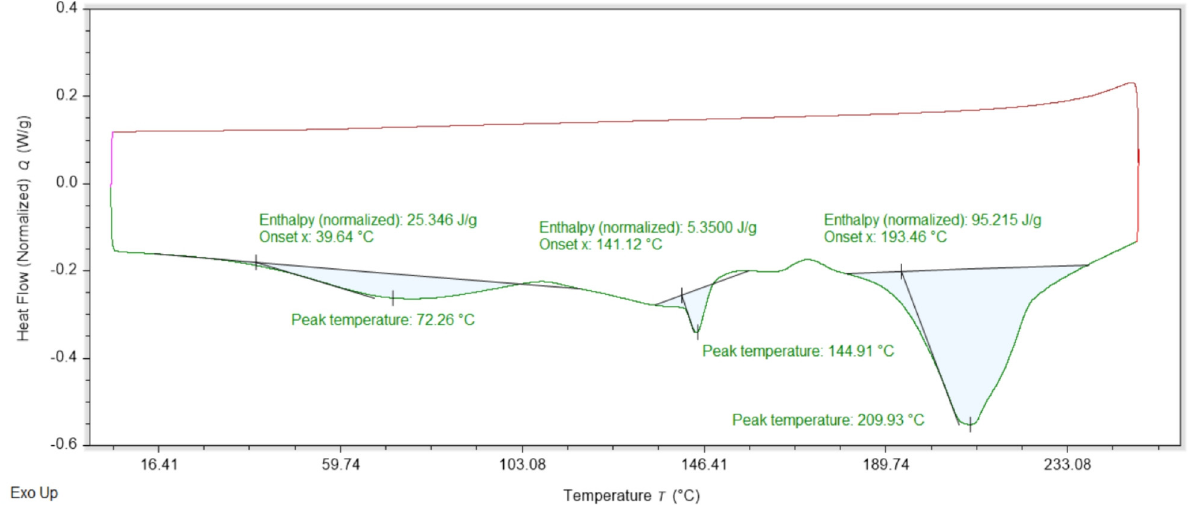
Figure 4. Graphical representation of the results from the DSC analyses for DMG.0.5H 2 O. The red line corresponds to the cooling stage from 250 to 0 °C.